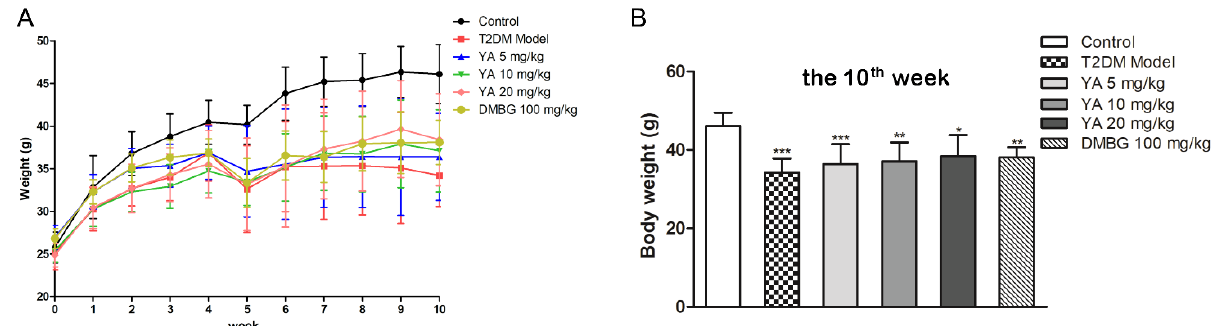
Figure 5. Effects of YA on body weight of T2DM mice. ( A ) Body weight differences between the different mouse groups. ( B ) Body weights of different groups mice on the 10th week. Data are expressed as mean ± SD for each group. ( n = 8) (DMBG: metformin) (*** p < 0.001 vs. Control; ** p < 0.01 vs. Control; * p < 0.05 vs. Control).